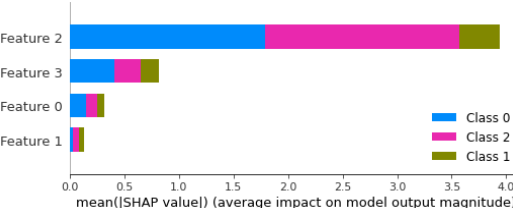
Figure 9. SHapley Additive exPlanations (SHAP) analysis results for the feature based classification method used in workflow